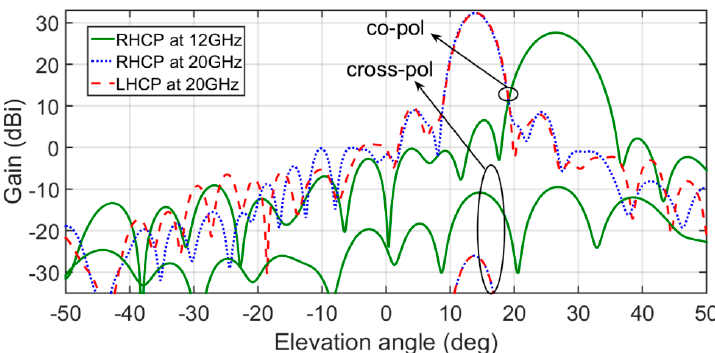
Figure 10. Simulated radiation patterns in elevation plane at 12 GHz for RHCP and 20 GHz for both RHCP and LHCP provided by designed reflectarray that radiates three circular polarization focused beams.